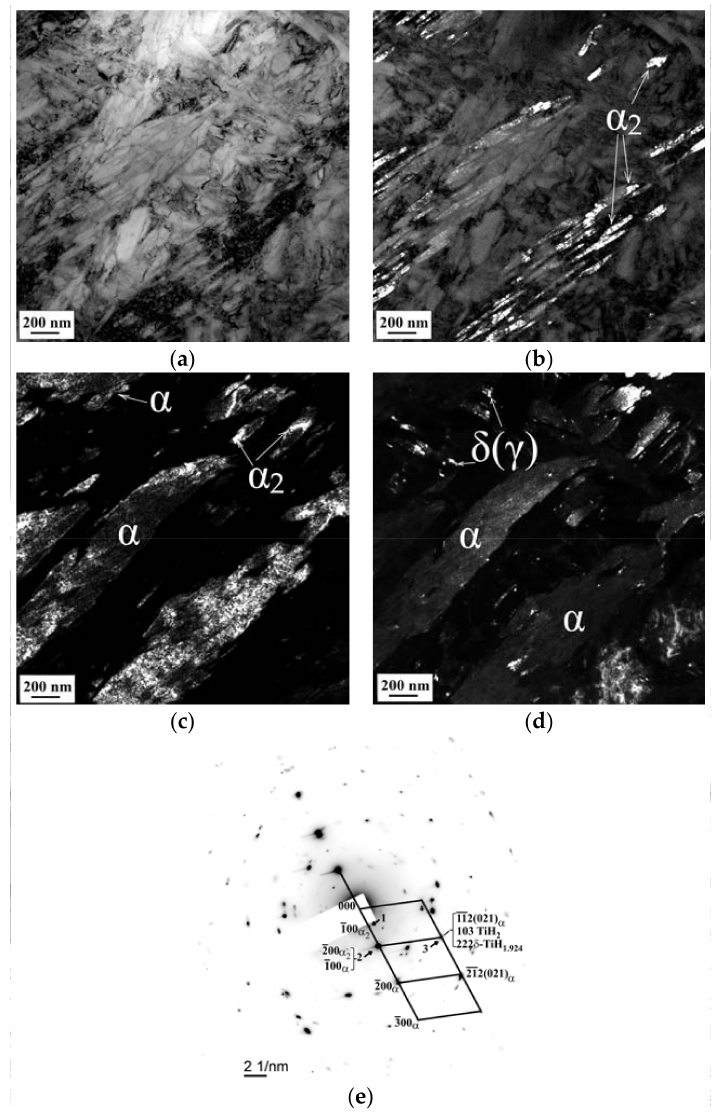
Figure 7. TEM bright- ( a ) and dark-field images ( b – d ) and associated SAED pattern ( e ) of the microstructure of EBM titanium Ti-6Al-4V parts after hydrogenation to 0.58 wt. %; b—the dark-field image obtained with 100 Ti 3 Al superstructure reflection (marked by an arrow 1); c—the dark-field image obtained with 200 Ti 3 Al and 100 α -Ti reflection (marked by an arrow 2); d—the dark-field image obtained with 112 α -Ti, 103 γ -TiH and 222 δ - TiH phase reflections (marked by an arrow